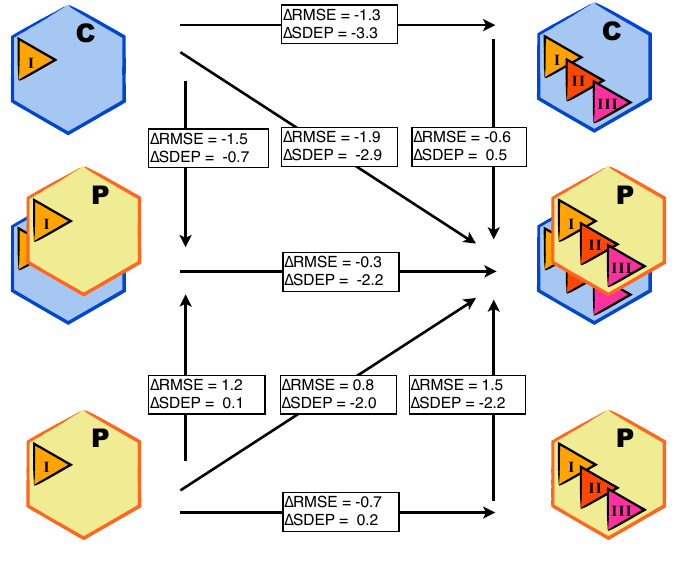
1 ) in root-mean-square errors (RMSEs) and standard Figure 4. Differences ( ∆ , in kJ mol − deviation of prediction errors (SDEPs) between the LIE models presented in Figure 3. The models on the left include results of MD simulations starting from a single active site binding orientation of the aryloxypropanolamine compounds (from the most populated clusters I), models on the right include results of MD simulations started from three different starting poses (originating from clusters I, II and III). The top-row models are based on results of simulations starting from protein conformation CHZ170 (C). Models in the bottom row include simulations starting from the PPD70 protein template (P). Models in the middle row include results of P and C